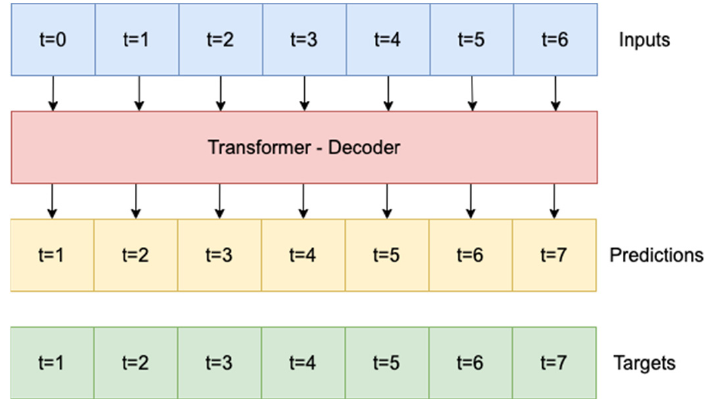
Figure 7. Principle of prediction for the future solar irradiance.